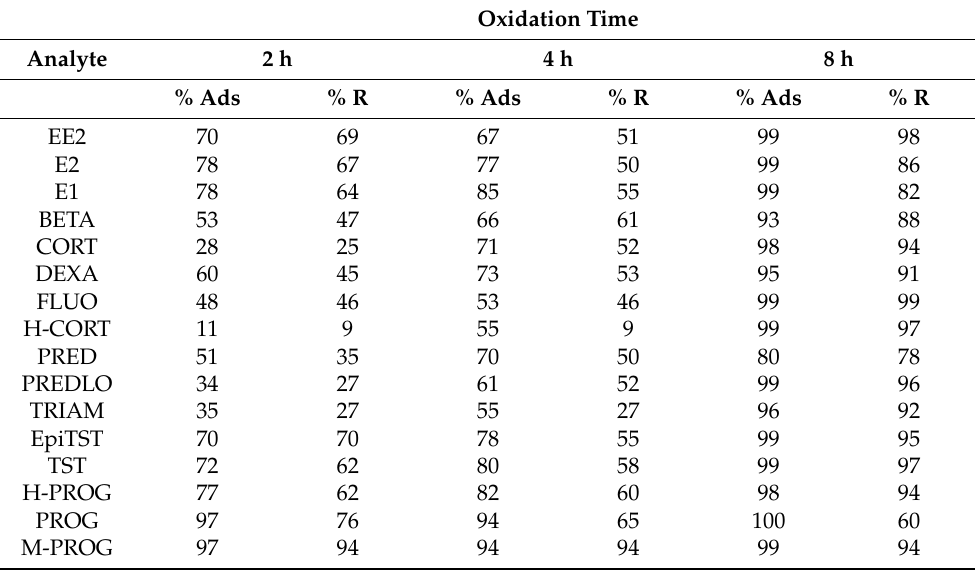
Table 1. Adsorbed percentage (% Ads) and mean recovery of analytes in the sample (% R, n = 2) observed testing the oxidized material at different times (2 h, 4 h, and 8 h) on 50 mL of tap water spiked with 2 µ g L − 1 of each